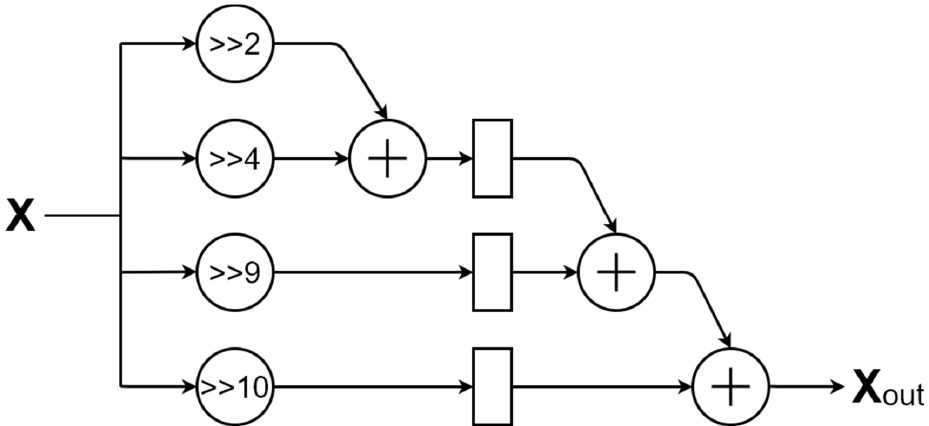
Figure 8. The architecture of the hardware-sharing machine with scale factor_2.